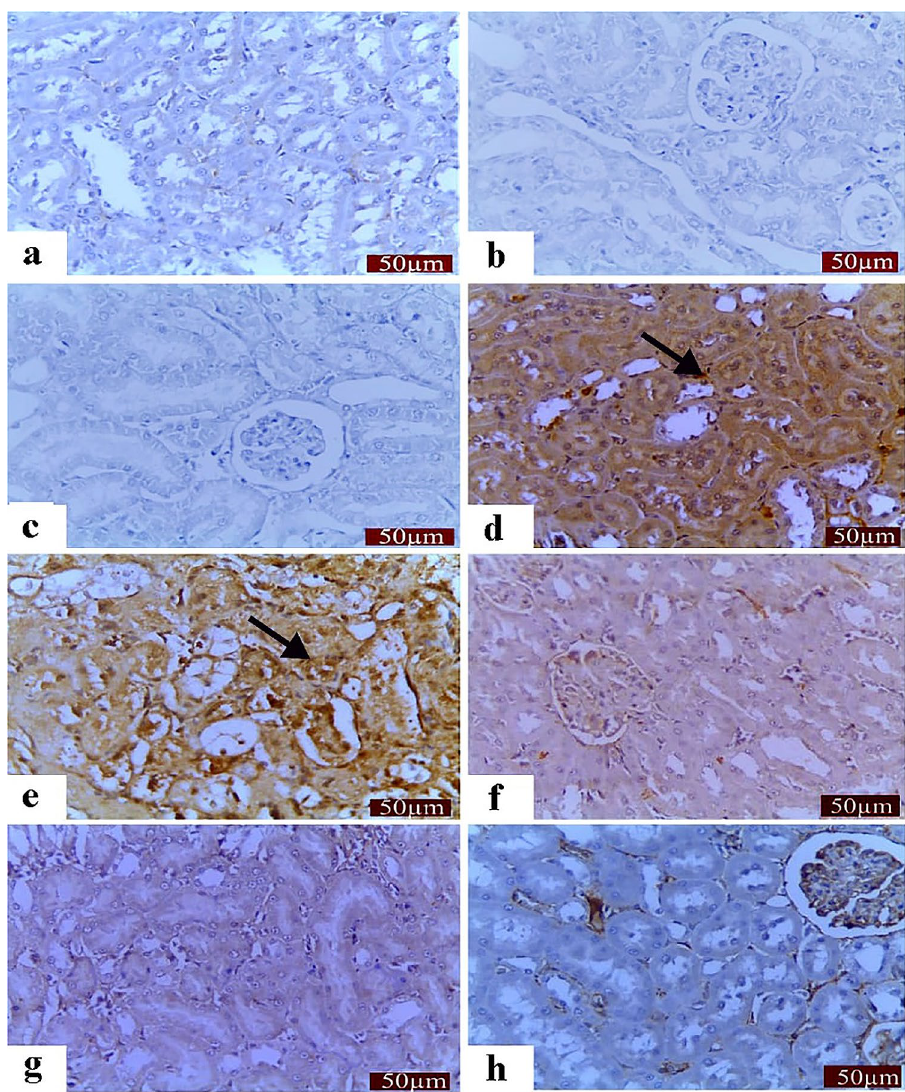
( C ) groups showing the negative immunostaining reaction. ( d ) and ( e ) treated group with CP showed severe immunostaining reaction. ( f ) Caspase staining in the LP + CP group showing moderate immunostaining. ( g ) Caspase staining in the NAC + CP group showing moderate immunostaining. ( h ) Caspase staining in the LP + NAC + CP group showing mild immunostaining. Scale bar = 50